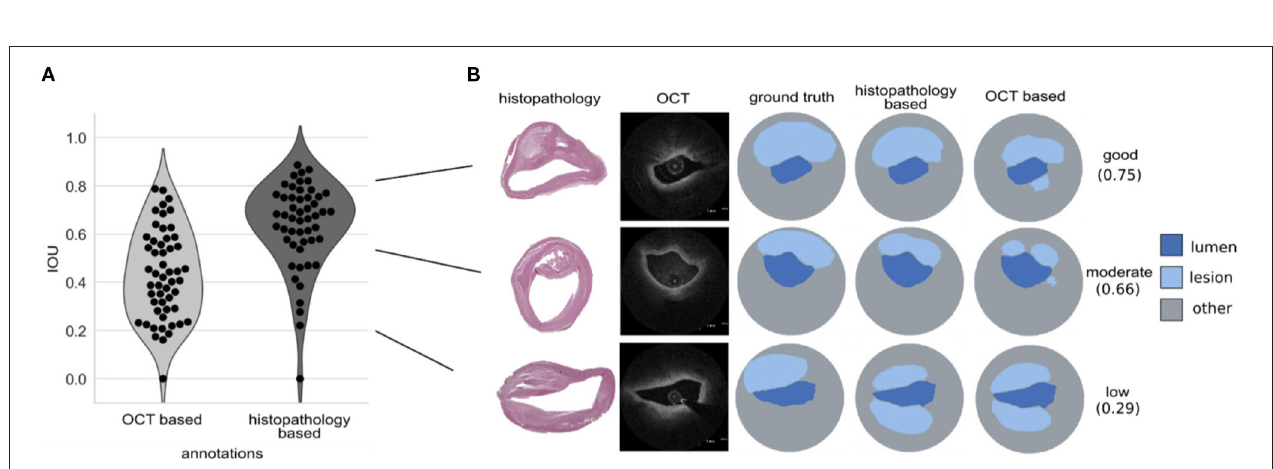
FIGURE 4 | DeepAD predicts atherosclerotic lesion tissue on unseen test patients with good performance. (A) Intersection over union (IOU) scores across test sets for atherosclerotic tissue predictions from the OCT only and histopathology-based algorithm (DeepAD), here visualized for every test sample as a dot in the violin plot. (B) Examples of predicted atherosclerotic lesions from OCT and histopathology based algorithm: good performance prediction (top, 0.75 IOU, almost all of the region annotated in “ground truth” is predicted by DeepAD), moderate performance (middle, 0.66 IOU, most of the region annotated in “ground truth” is predicted by DeepAD) and low performance (bottom, 0.29 IOU, false-positive prediction of a region from 6-9 o’clock which was not annotated in “ground truth”).